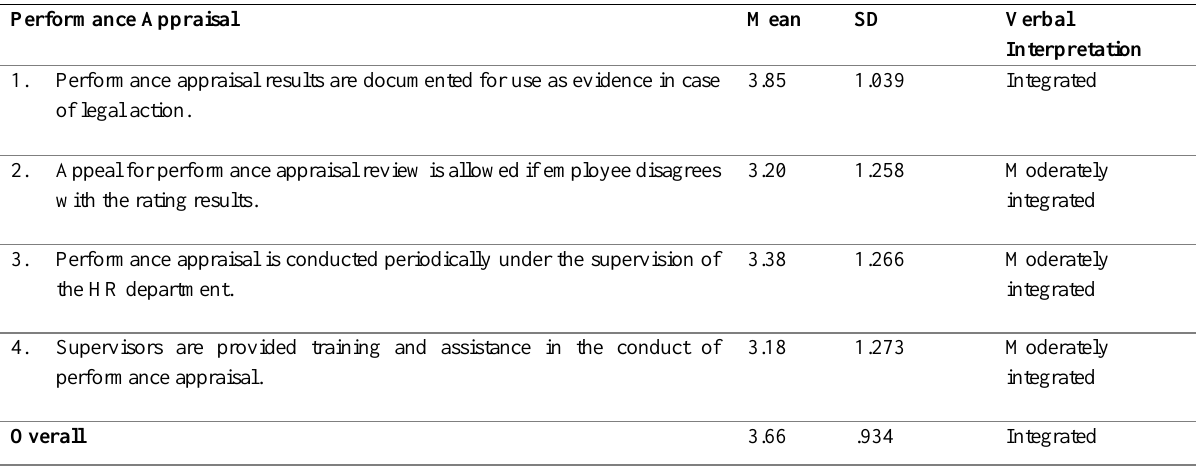
Table 3: Extent of Integration of Leadership to Performance Appraisal as Perceived by Respondents Performance Appraisal Mean SD Verbal